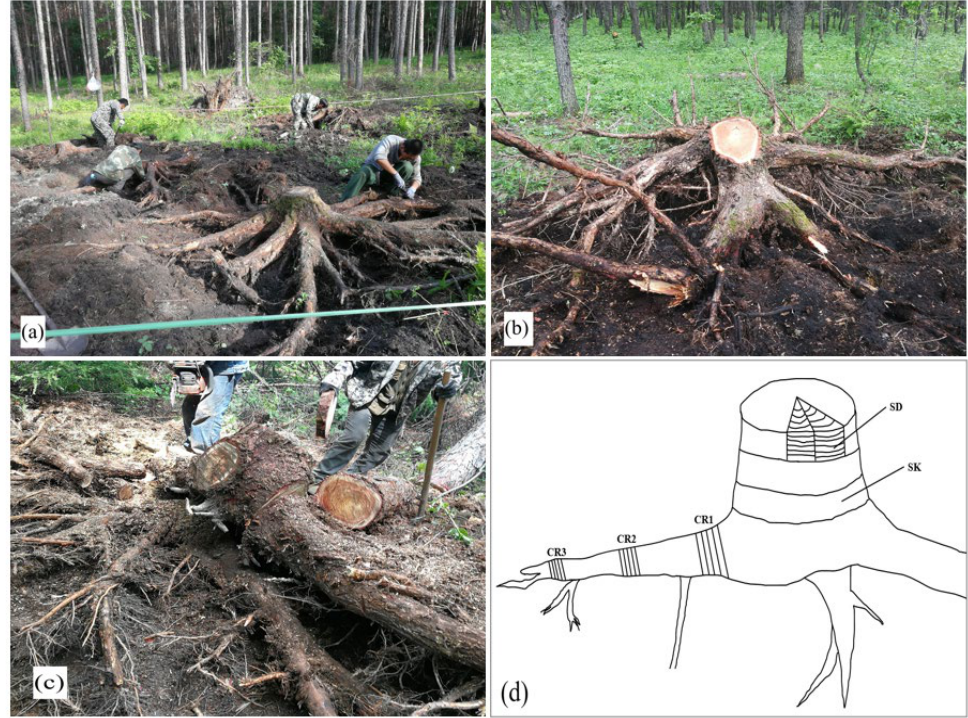
Figure 1. Stump and coarse root harvest operations ( a – c ) and belowground biomass compartments ( d ) in Larix olgensis. Table 2. Sampled information of Larix olgensis .